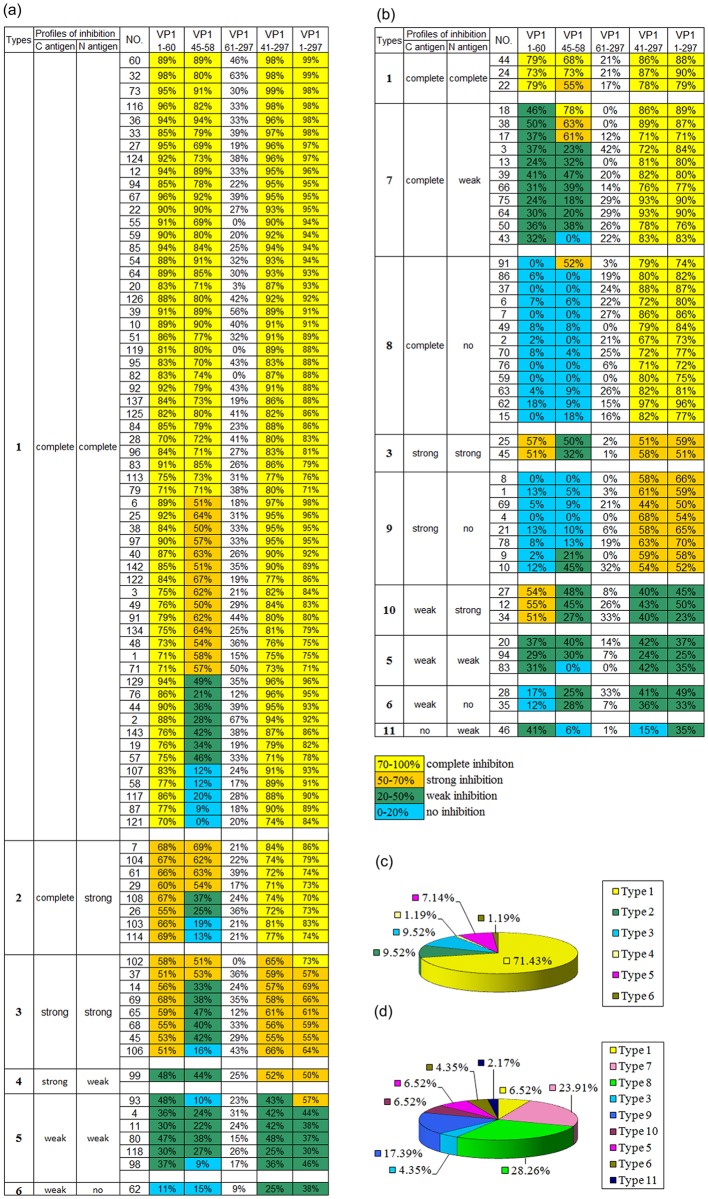
Characterization of different types of inhibition profiles against anti-CA16 antibody response by five antigens between the Shanghai blood donors (a) and Shanxi individuals (b).The inhibition profiles against anti-CA16 reaction were sorted based on the combination of inhibition degrees by VP11-60 and VP141-297. Eleven types of inhibition profiles were defined in both groups. Individual values are shown in colour as indicated beneath Fig 4b, with yellow representing the strongest inhibition degree. The constituent ratios of the types of inhibition profiles in the Shanghai blood donors (c) and Shanxi individuals (d) are shown.